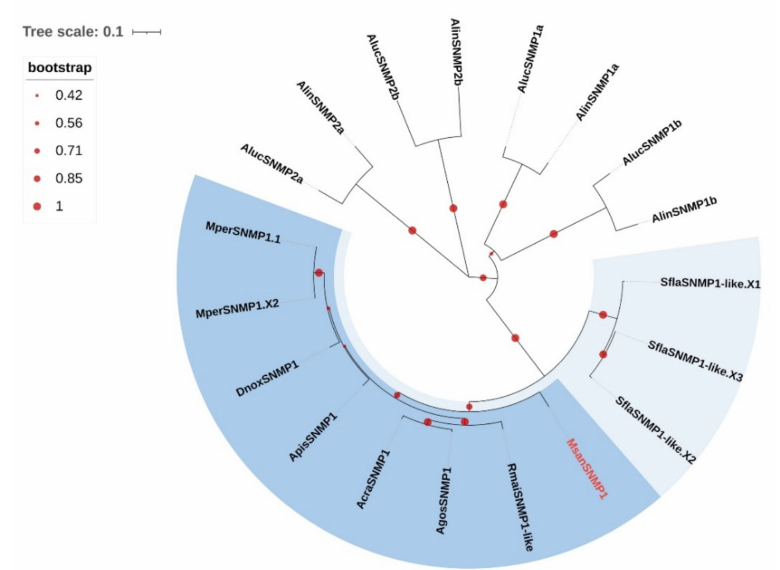
Figure 7. Phylogenetic tree of 19 sensory neuron membrane proteins (SNMPs) from 10 Hemiptera species. The phylogenetic tree of Hemiptera SNMPs was built using 19 SNMP sequences from eight different aphid species (2 from My. persica ; 3 from Si. flava ; 1 from Ac. pisum ; 1 from D. noxia ; 1 from A. craccivora ; 1 from A. gossypii ; 1 from R. maidis ; 1 from M. sanborni ) and two plant bugs (4 from Ad. lineolatus ; 4 from Ap. lucorum ).